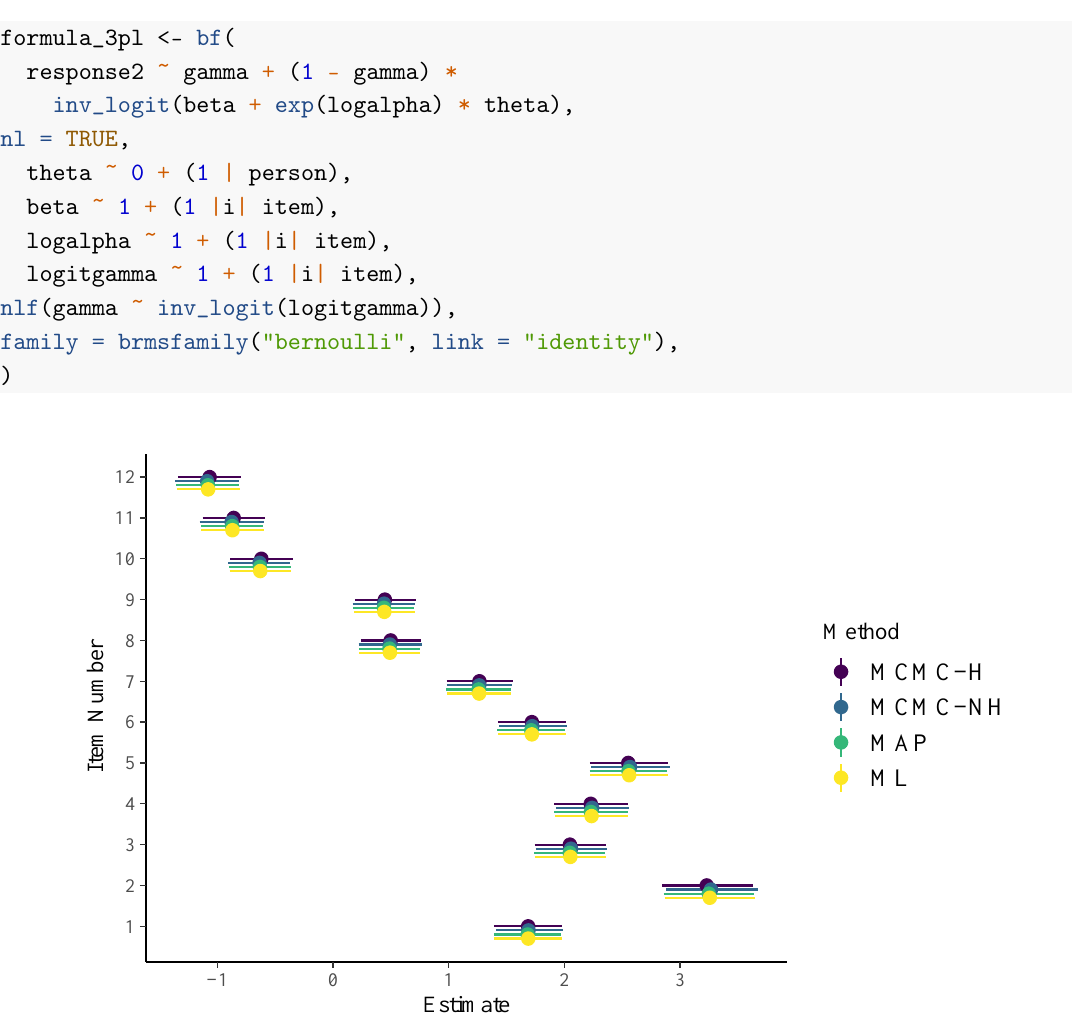
Figure 1. Item parameters of the 1PL model. Horizontal lines indicate 95% uncertainty intervals.